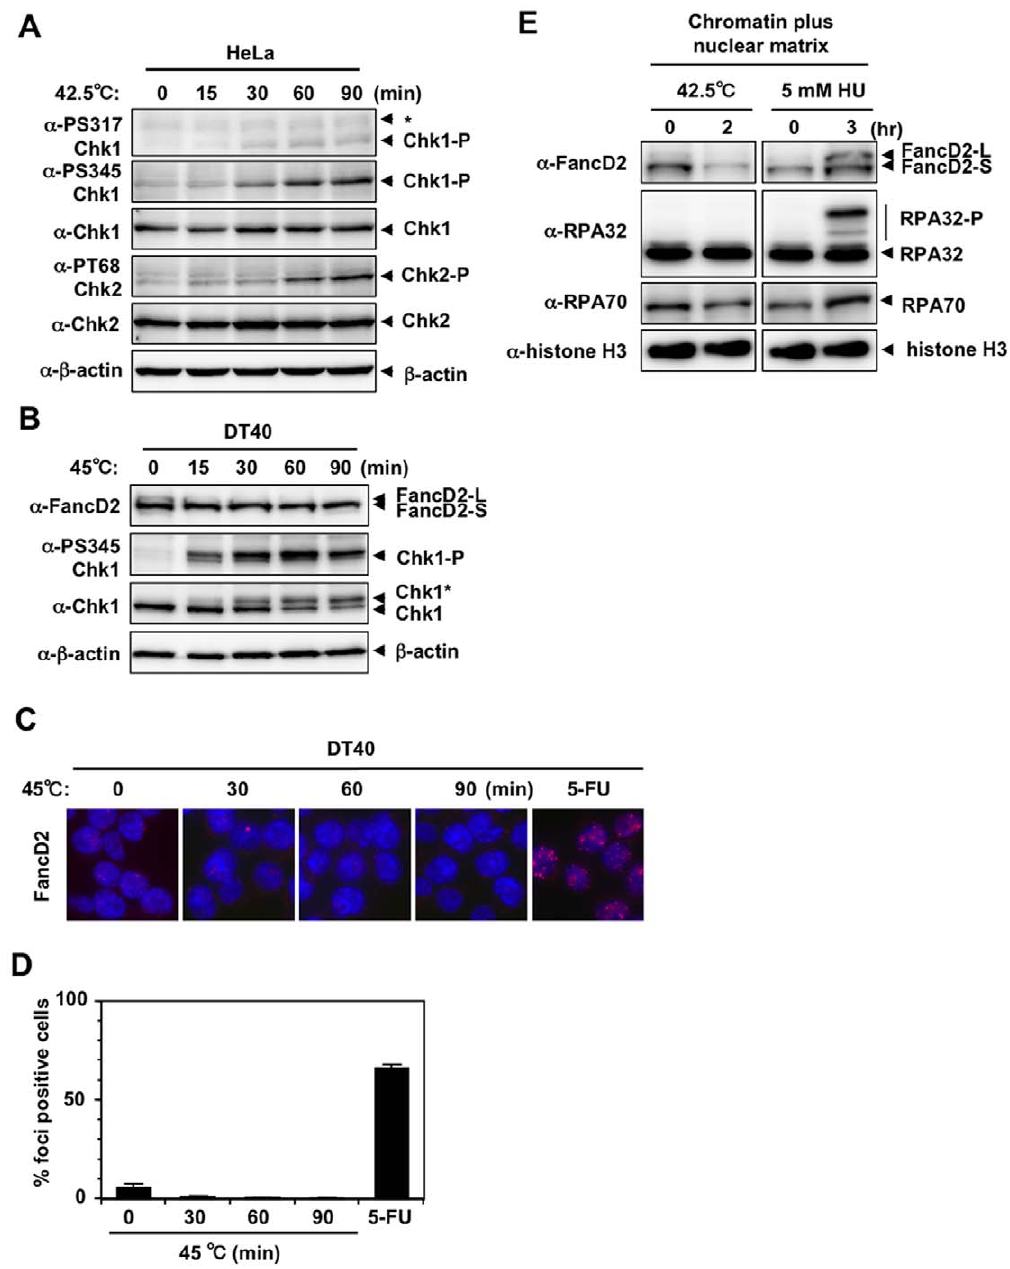
Figure 1. DNA damage response by heat stress. A. Western blot. HeLa cells were cultured at 42.5 u C for the indicated time. Non-specific bands were indicated as *. B. Western blot. Wild-type DT40 cells were cultured at 45 u C for the indicated time. C. Nuclear foci of FancD2. Wild-type DT40 cells were cultured at 45 u C for the indicated time. Wild-type DT40 cells cultured in the presence of 200 m M 5-FU for 16 hours are shown as a positive control (5-FU) [23]. D. The percentage of FancD2 nuclear foci-positive cells in C is shown. E. Subcellular fractionation of HeLa cells cultured at 42.5 u C for 2 hours or at 37 u C in the presence of 5 mM hydroxyurea (HU) for 3 hours. Chromatin plus nuclear matrix fraction was isolated as described in Materials and Methods. Ten m g (FancD2, RPA70 and RPA32) or 2 m g (histone H3) of protein were subjected to SDS-PAGE and Western